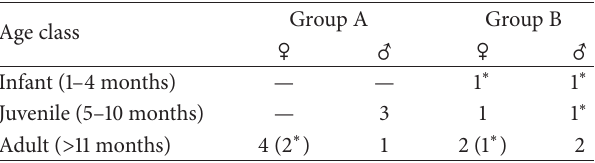
Table 1: Composition of the common marmosets groups in the study